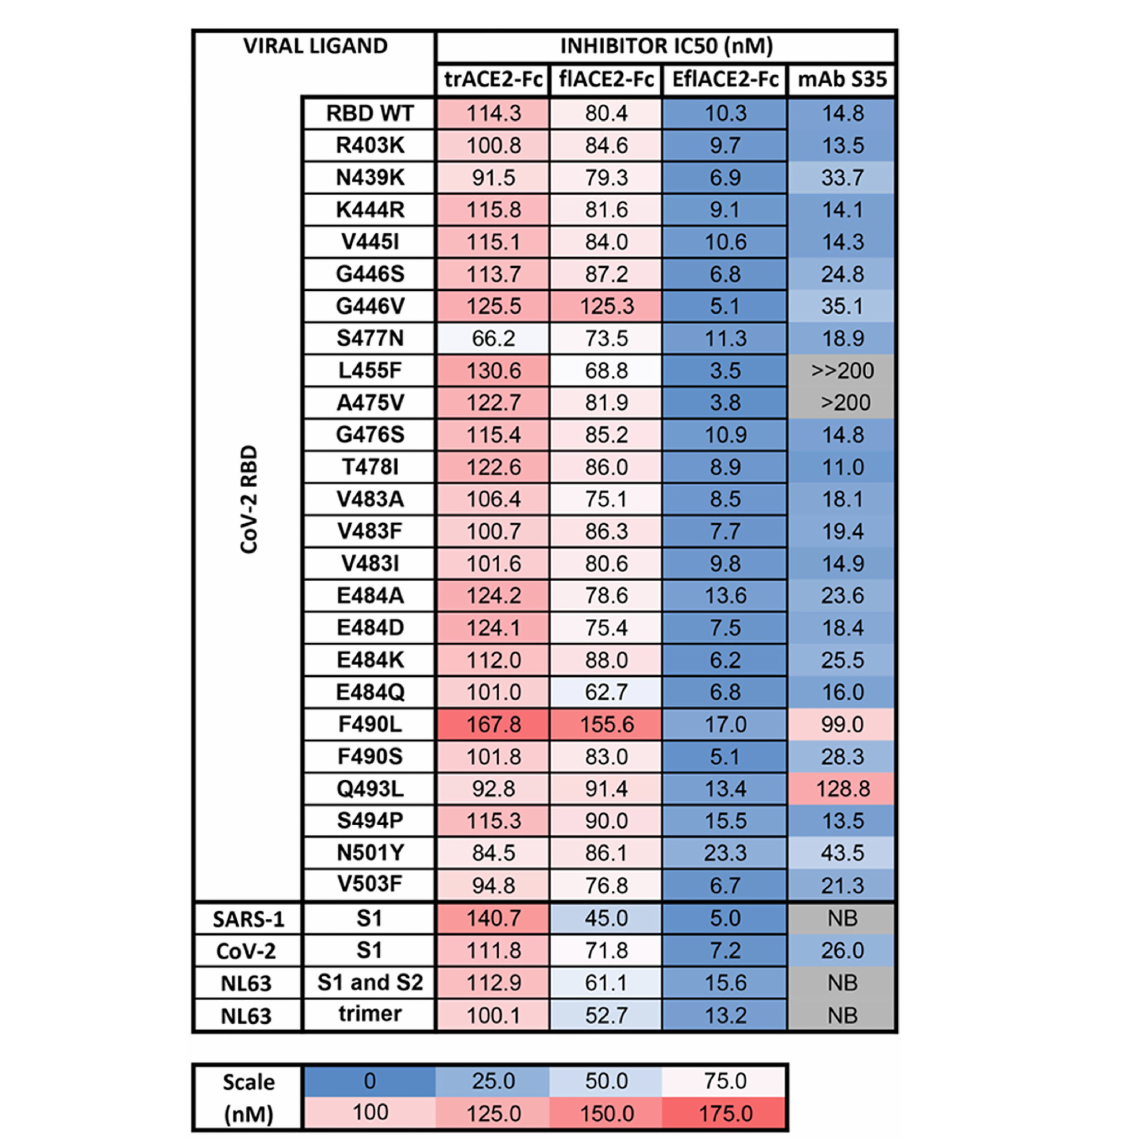
FIGURE 2 Human ACE2-Fc decoy proteins broadly inhibit binding to RBD variants and S from variants and related Sarbecoviruses. Biotinylated trACE2-Fc was incubated with a concentration series of unlabelled trACE2-Fc, fl ACE2-Fc, E fl ACE2-Fc fusion proteins or the inhibitory human mAb S35. Binding to RBD or S proteins coupled to beads was determined. Apparent IC50 (nM) values are indicated. NB, no